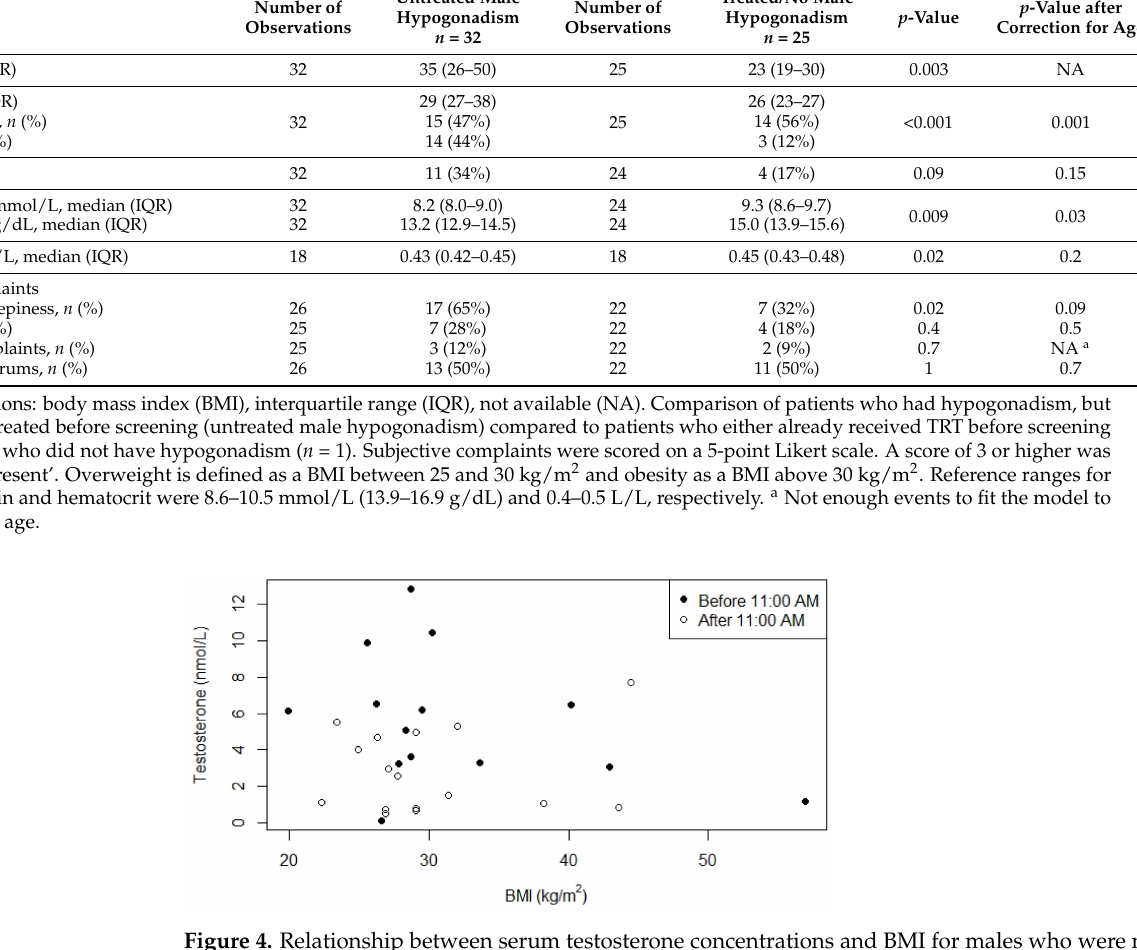
Figure 4. Relationship between serum testosterone concentrations and BMI for males who were not receiving testosterone replacement therapy. p -value for the relationship between BMI and serum testosterone concentration measured before 11:00 A.M. was 0.4 (0.1 after correction for age), Kendall’s Tau was -0.19. p -value for the relationship between BMI and serum testosterone concentration measured after 11:00 A.M. was 0.9 (1.0 after correction for age), Kendall’s Tau was 0.03.